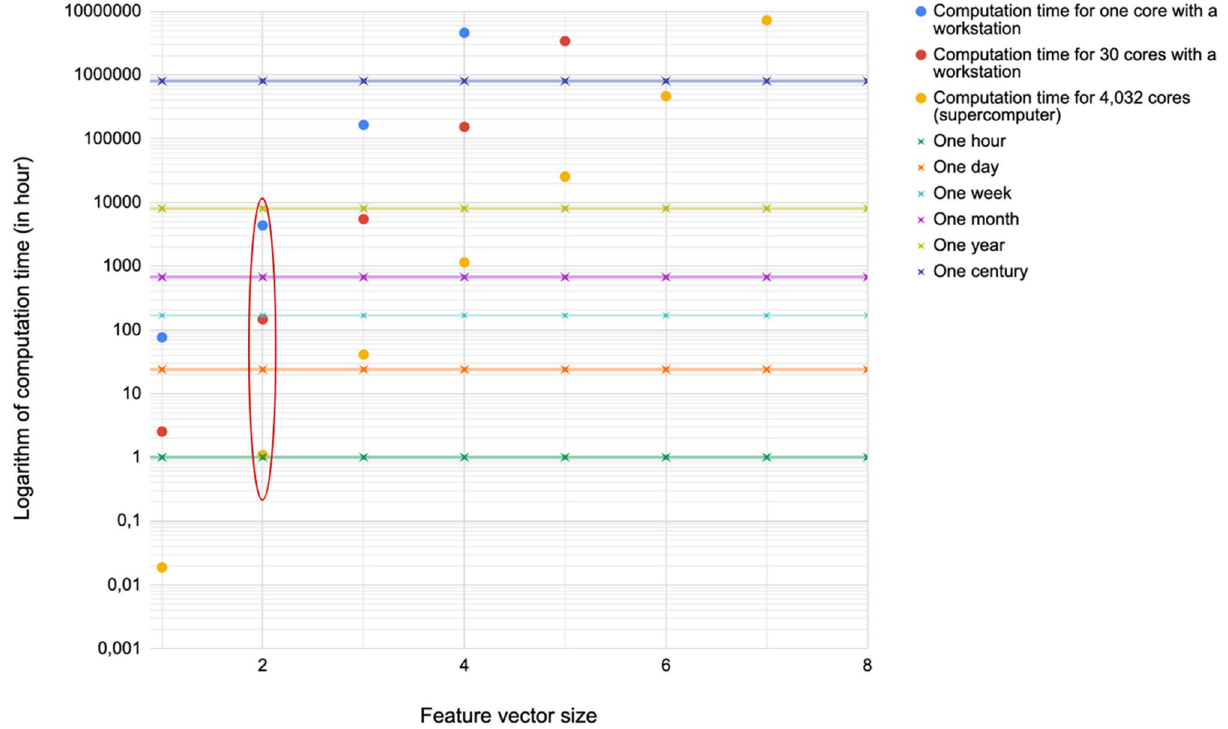
Figure 2. Computation time (logarithmic scale) for 114 features, different computational configurations and according to vector size (n = 2). The horizontal lines represent different time scales (from an hour to a century) and an averaged computation time for one combination was estimated to be equal to 40 min. The circled points represented acceptable processing times for the three different computation configurations and lead to a maximal vector size of